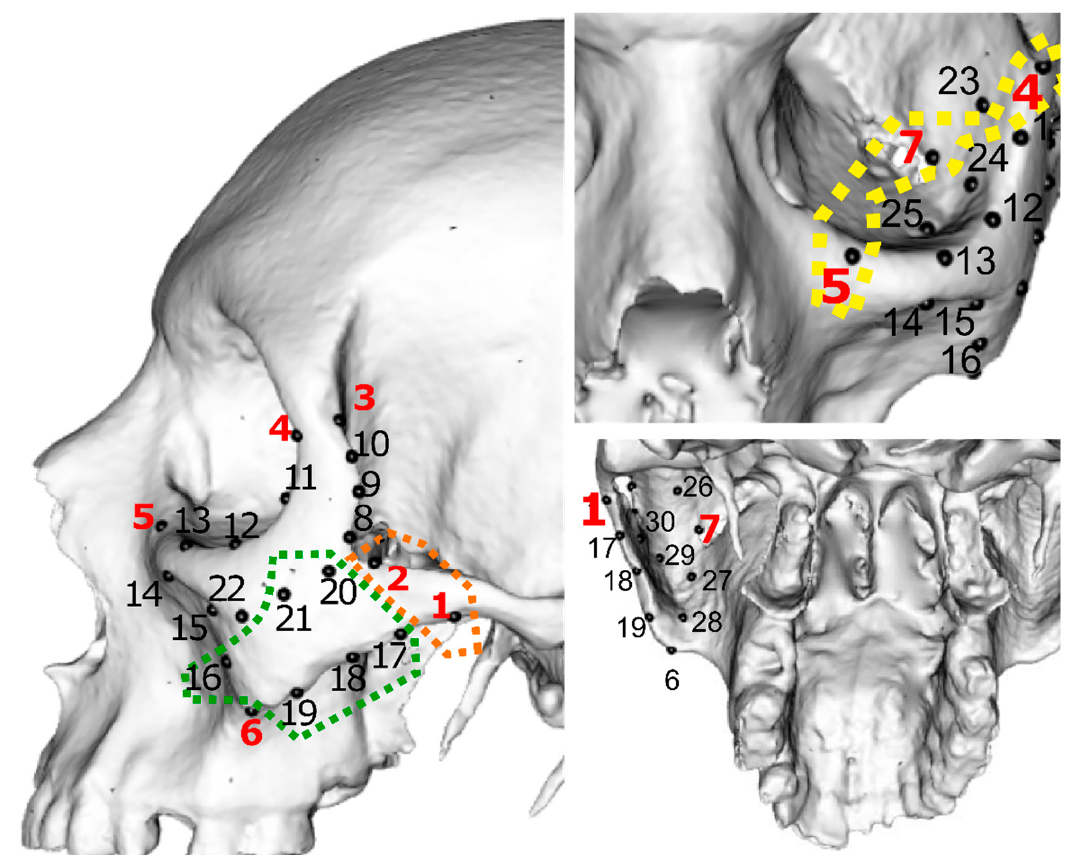
Figure 1. Landmark configuration used in this study. Fixed landmarks are indicated by red numbers (1–7, Table 2) while semi-landmarks are given by black numbers (8–30). Study cases are enclosed with dots: Case 1 (orange), Case 2 (yellow) and Case 3 (green).